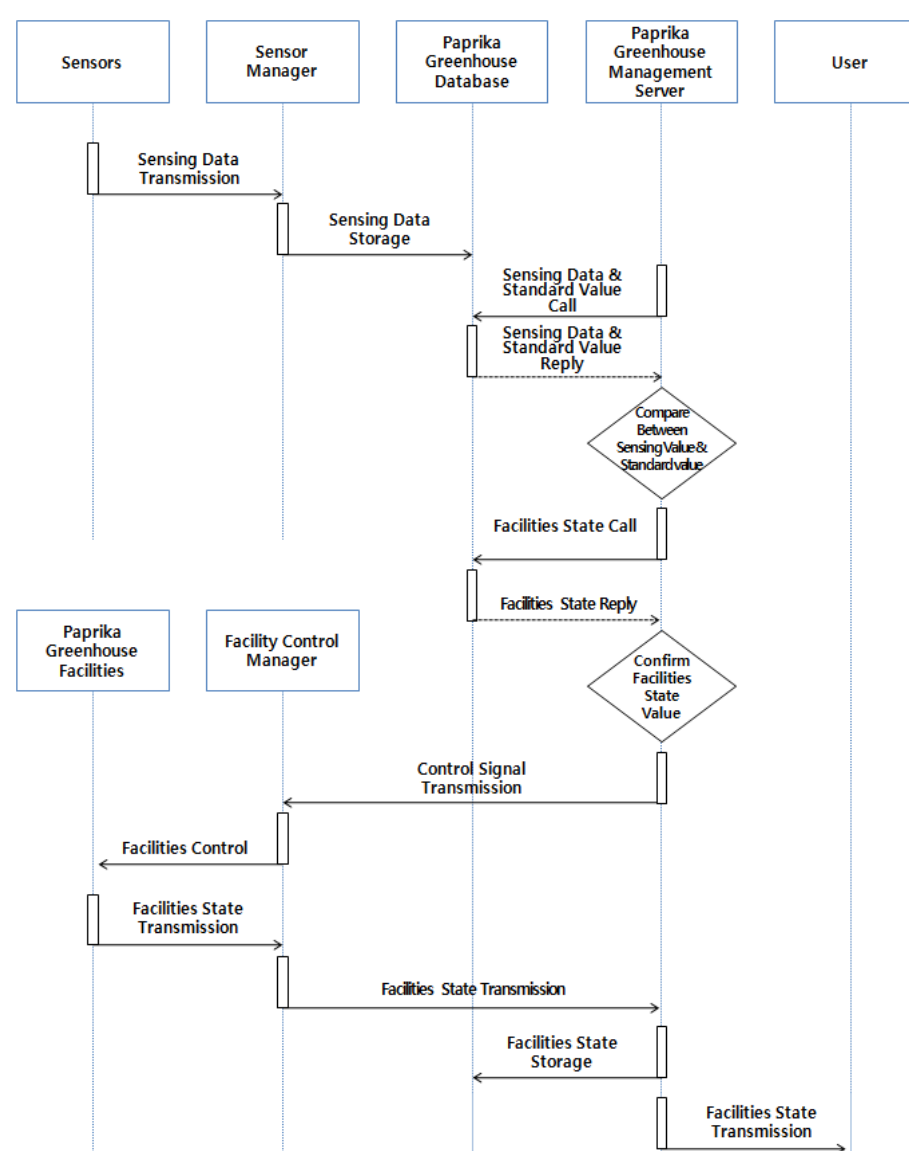
Figure 4. Paprika Facilities Automatic Control Services